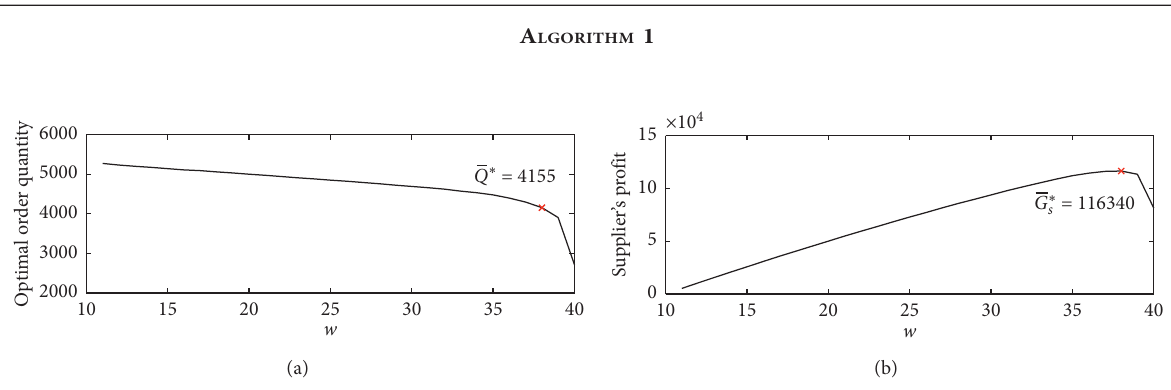
Figure 2: Optimal order quantity and supplier’s profit at wholesale